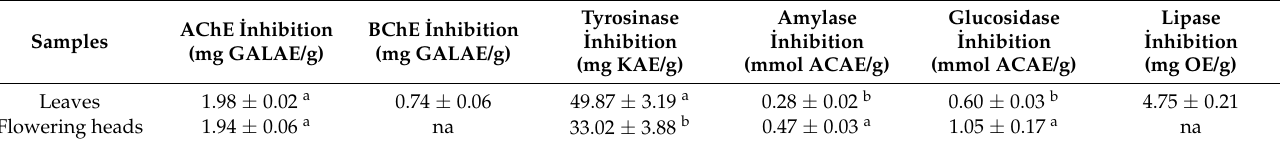
Table 3. Enzyme inhibitory activity of C. alpina